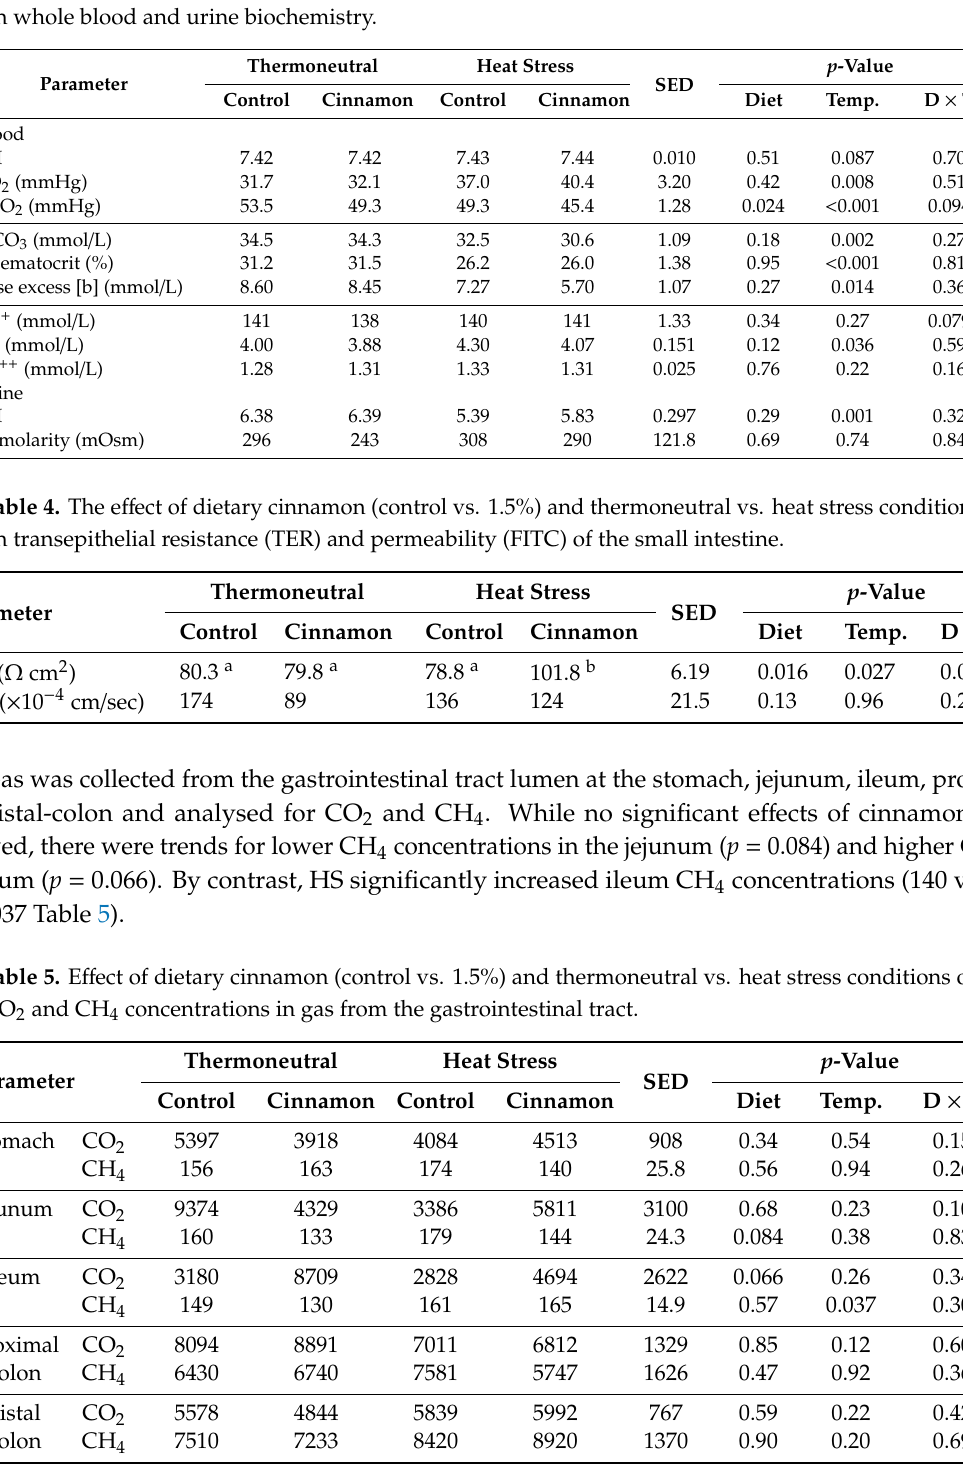
Table 3. E ff ect of dietary cinnamon (control vs. 1.5%) and 7 d thermoneutral vs. heat stress conditions on whole blood and urine biochemistry.